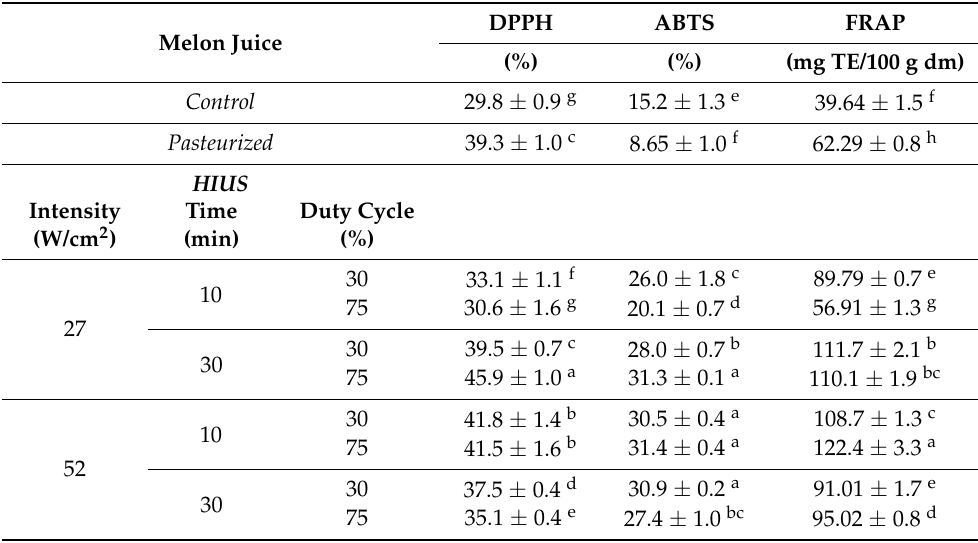
Table 1. Antioxidant capacity of control (unprocessed), pasteurized and HIUS processed melon ( Cucumis melo ) juice. Different letters above the bars indicate statistical difference in treatments ( p < 0.05) ( n =